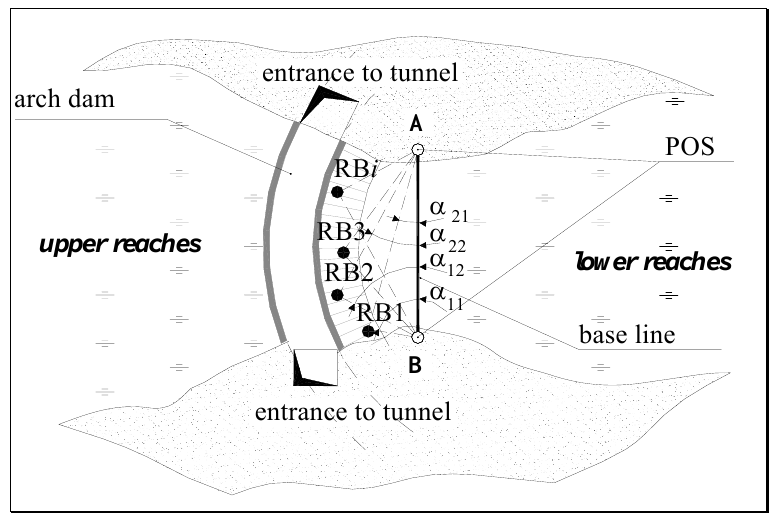
Figure 4. Placement of two vertical POSs for arch dam